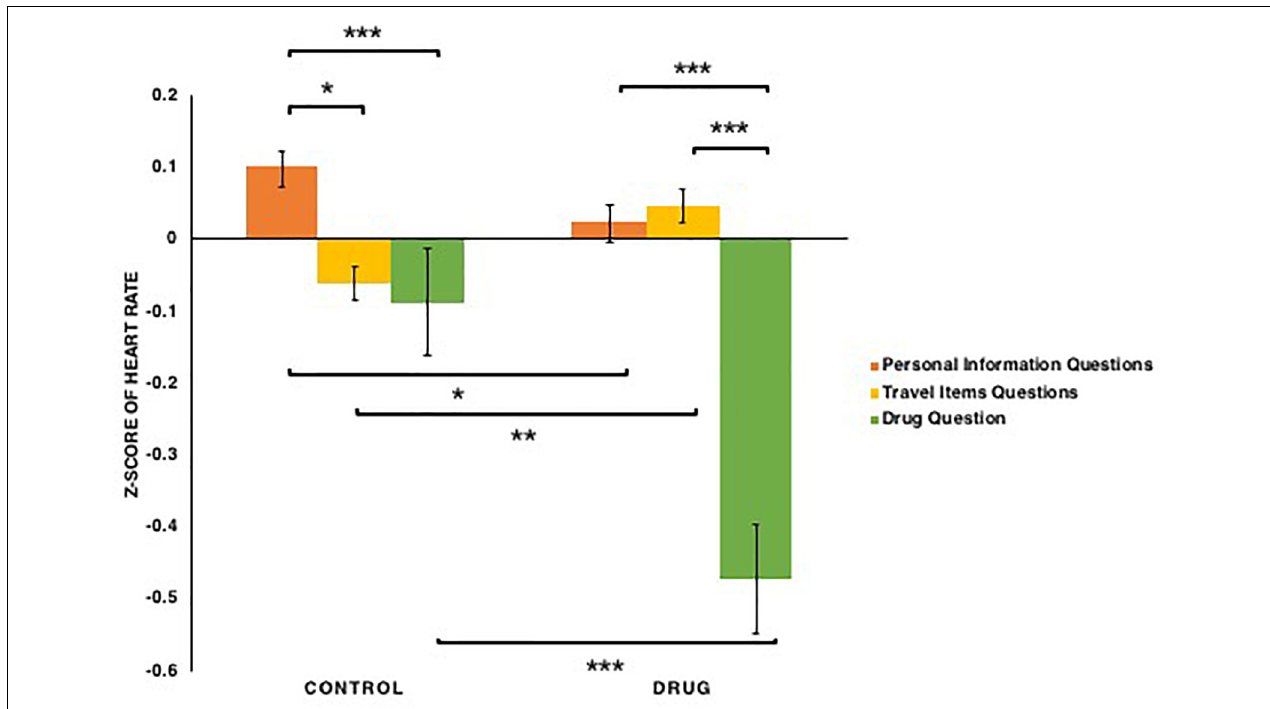
FIGURE 6 | The z -scores of the heart rate among participants in the control and drug conditions when answering three types of questions: basic personal information, carrying common travel items, carrying drugs. Note that ∗ p < 0.05, ∗∗ p < 0.01, ∗∗∗ p < 0.001. The error bars SEs.